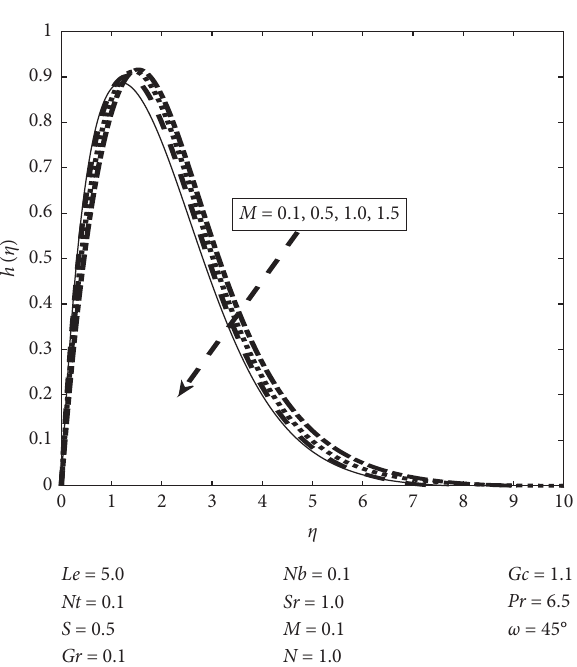
Figure 2: Angular velocity for several values of M .